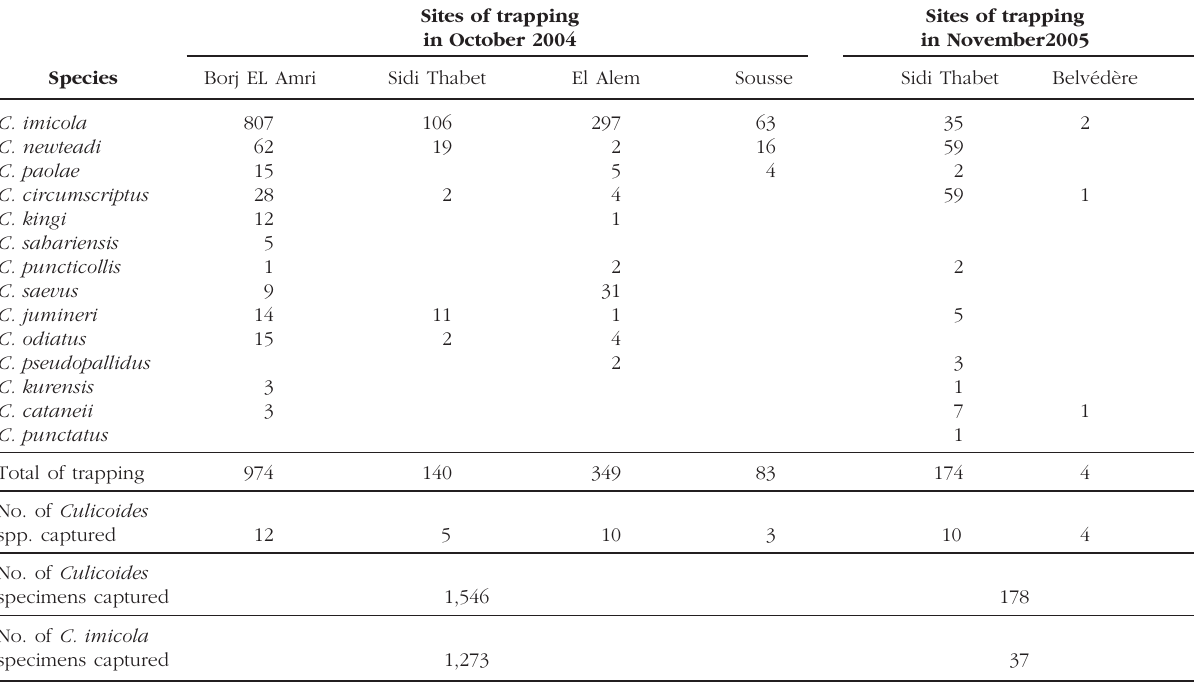
Table I. – Number of Culicoides specimens trapped for each species and in each